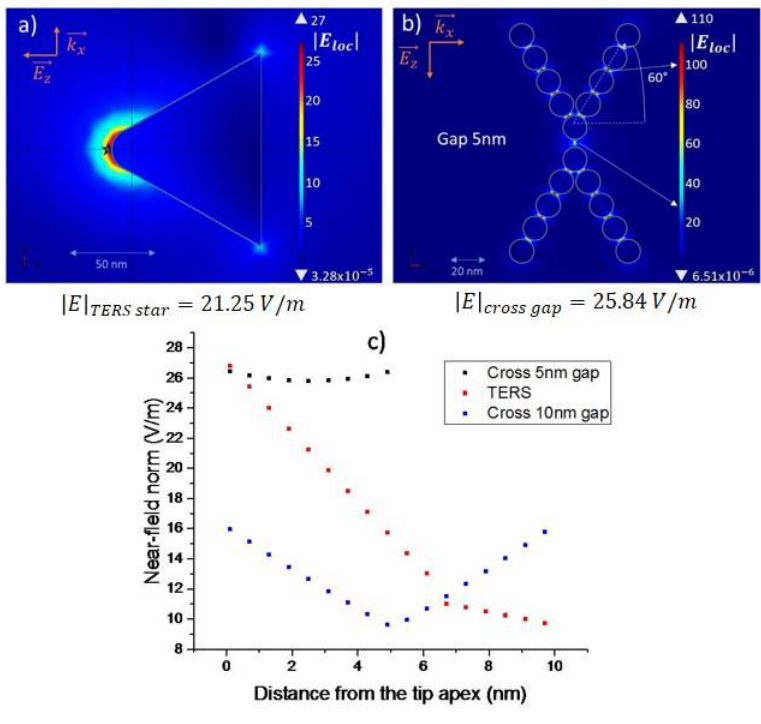
Figure 9. Computed near-field mappings ( a ) of a TERS tip; ( b ) a tip consisting of 9 NPs of 20 nm in diameter. The angles with respect to the normal are identical for the two structures, i.e., 60°. The respective values of the near-field norm were taken at the star point for the TERS tip, and at the white mark for the gold cross gap. ( c ) Amplitudes of the local electric field vs either the distance at the apex of the tip (TERS in red points) or the positions in the gap when the gap is only 5 nm (black) or 10 nm (blue points).